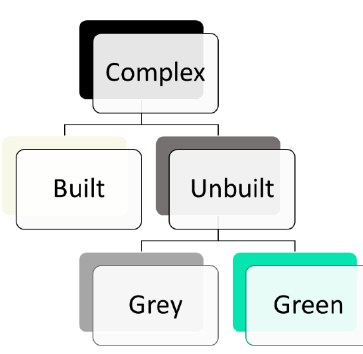
Figure 1. A hierarchy of areas in the complex. Initial analysis of HRHCs in the five cities yielded 81 com- plexes for further morphological analysis. General vari- ables were compiled for the morphological analysis, in- cluding the size of the complex, the size of the gray and green open areas in it, permeating areas, public and pri- vate areas, the number of buildings, the number of floors, the number of residential units, land uses, and